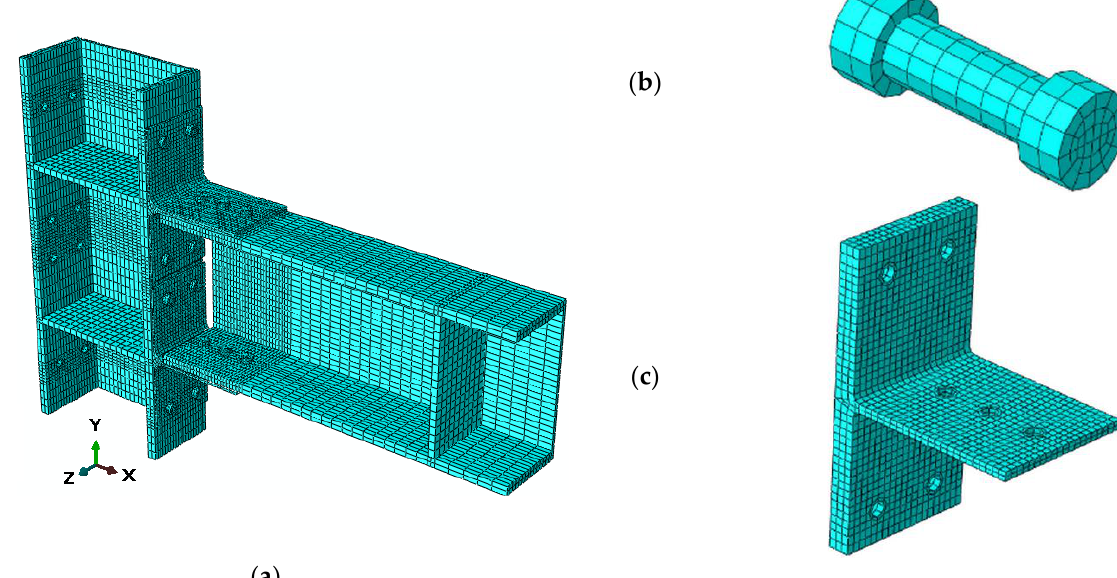
Figure 3. Details of T-stub connection mesh: ( a ) overview, ( b ) bolt, and ( c ) T-stub.